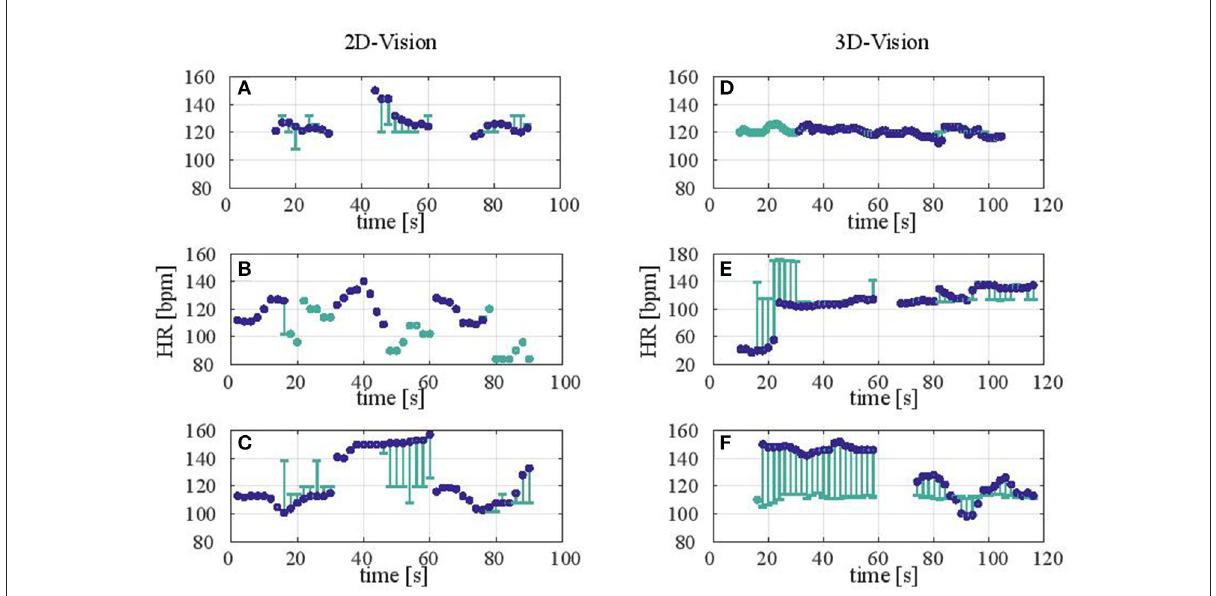
FIGURE6 (A–F) Representative measurement results comparing 2D and 3D vision (left and right column). Each plot shows the measured or calculated HR in bpm (beats per minute) of a newborn. The data encompasses the concatenated time intervals of all measurements performed on the respective patient. Here, each HR-value corresponds to an average over 2s. Blue circles denote HR values resulting from the reference Masimo pulse oximeter. Teal-colored circles and lines denote HR values resulting from the camera sensor. Whereas the teal circles show data points without a reference (i.e., the Masimo device failed to produce data), error bars show how much the camera-based data deviated from the HR measured by the Masimo